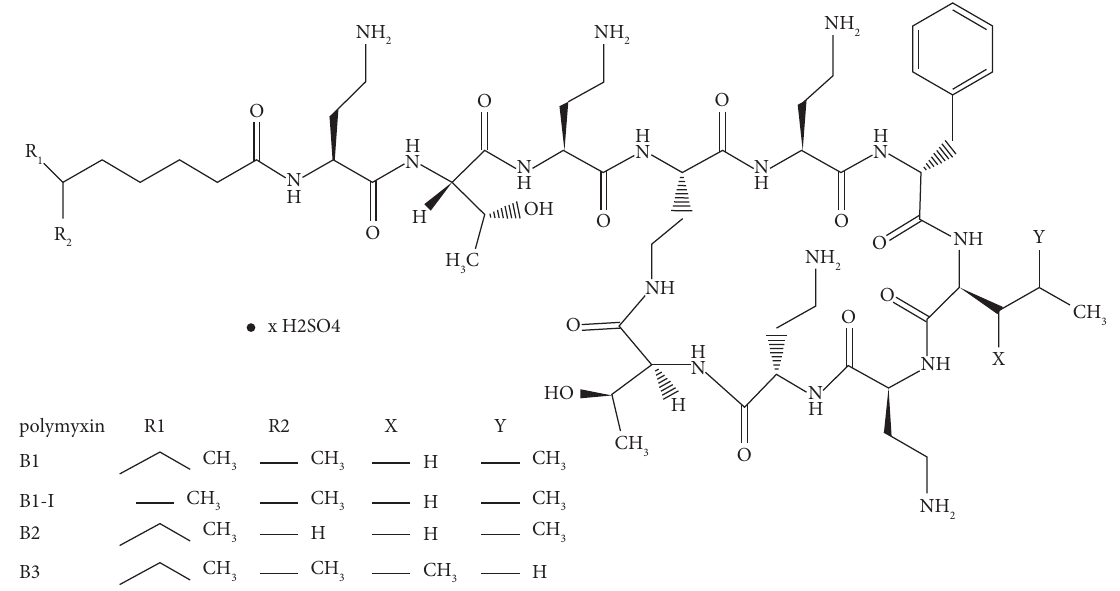
Figure 1: Te structure of